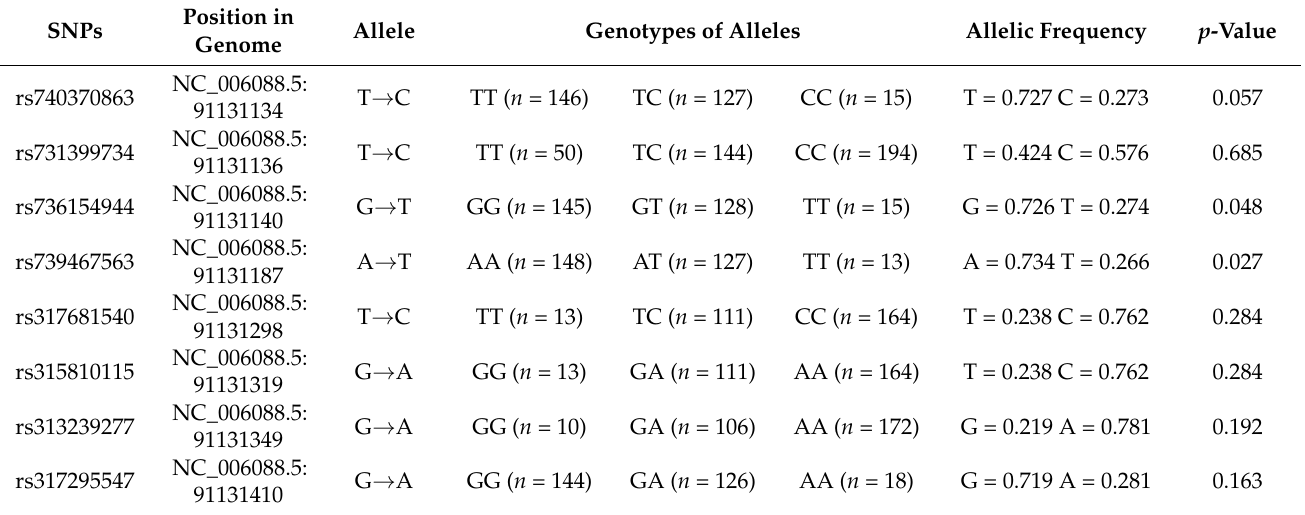
Table 1. The allele information of SNPs in the PROS1 5 (cid:48) flanking region.